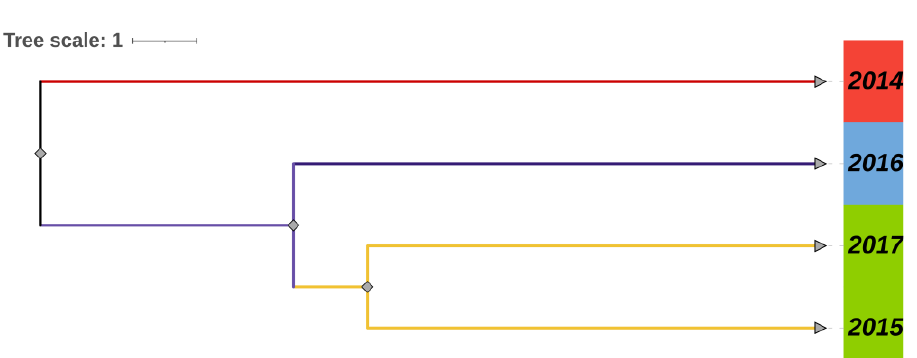
Figure 3. PCOA of four snail populations.